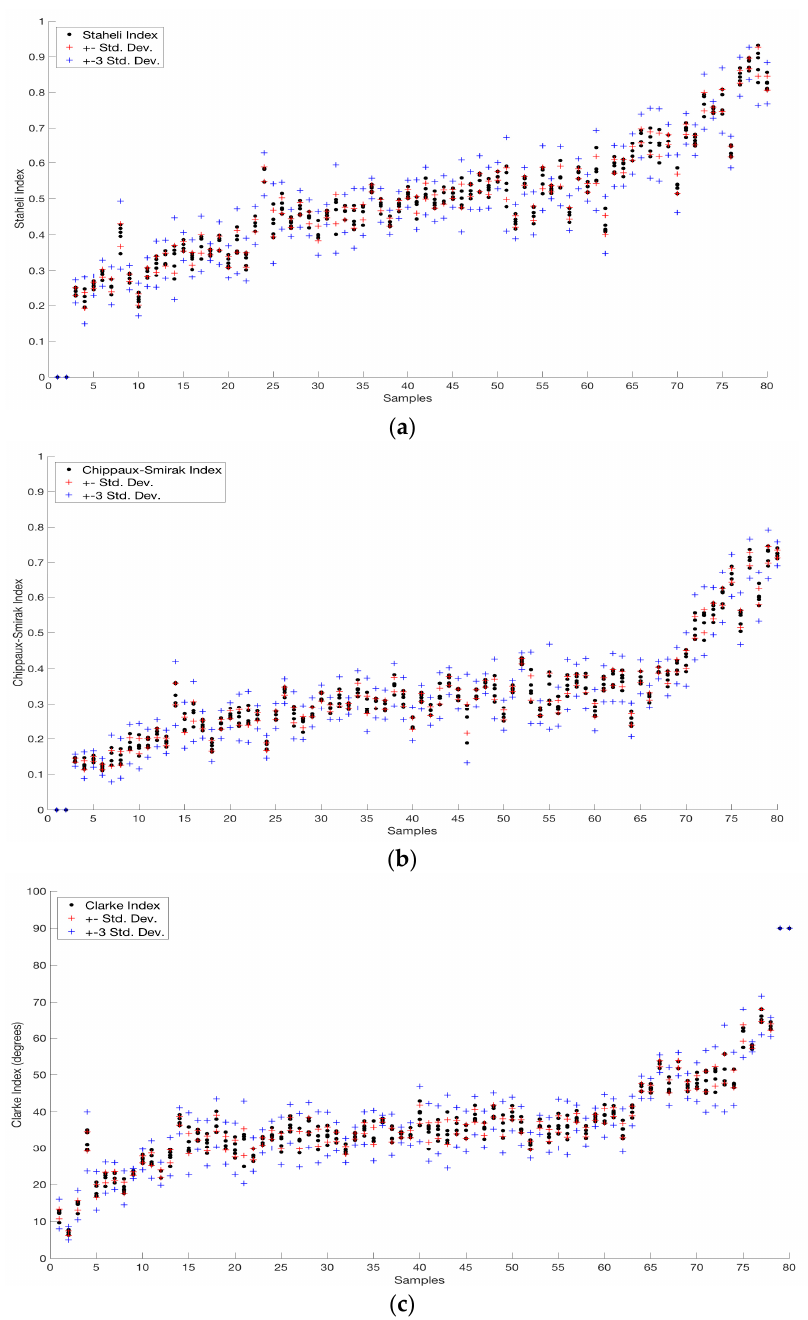
Figure 12. Precision analysis results where the vertical axis represents the value of the index and the horizontal axis is the right and left foot of the subjects arranged two by two: ( a ) Staheli index; ( b ) Chippaux-Smirak Index; ( c ) Clarke’s Angle.